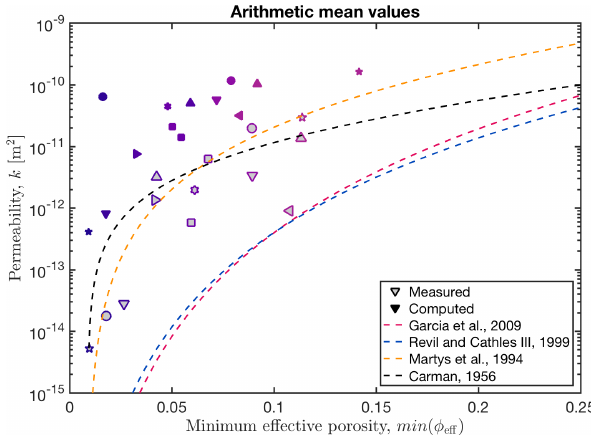
Figure E2. Computed and measured permeability against minimum effective porosity. Symbols of the same shape and colour represent the same sample. Samples with a grey face represent measured val- ues, whereas colour-only symbols stand for computed subsamples. The computed permeabilities represent the arithmetic mean values of all subsamples. To verify existing permeability parameteriza- tions, we plotted the relations of Revil and Cathles (1999), Garcia et al. (2009), Carman (1956), and Martys et al. (1994) against the experimental and numerical permeabilities. Note that estimated er- rors for the experimental permeability measurements (Table 1a) are smaller than the displayed symbols.